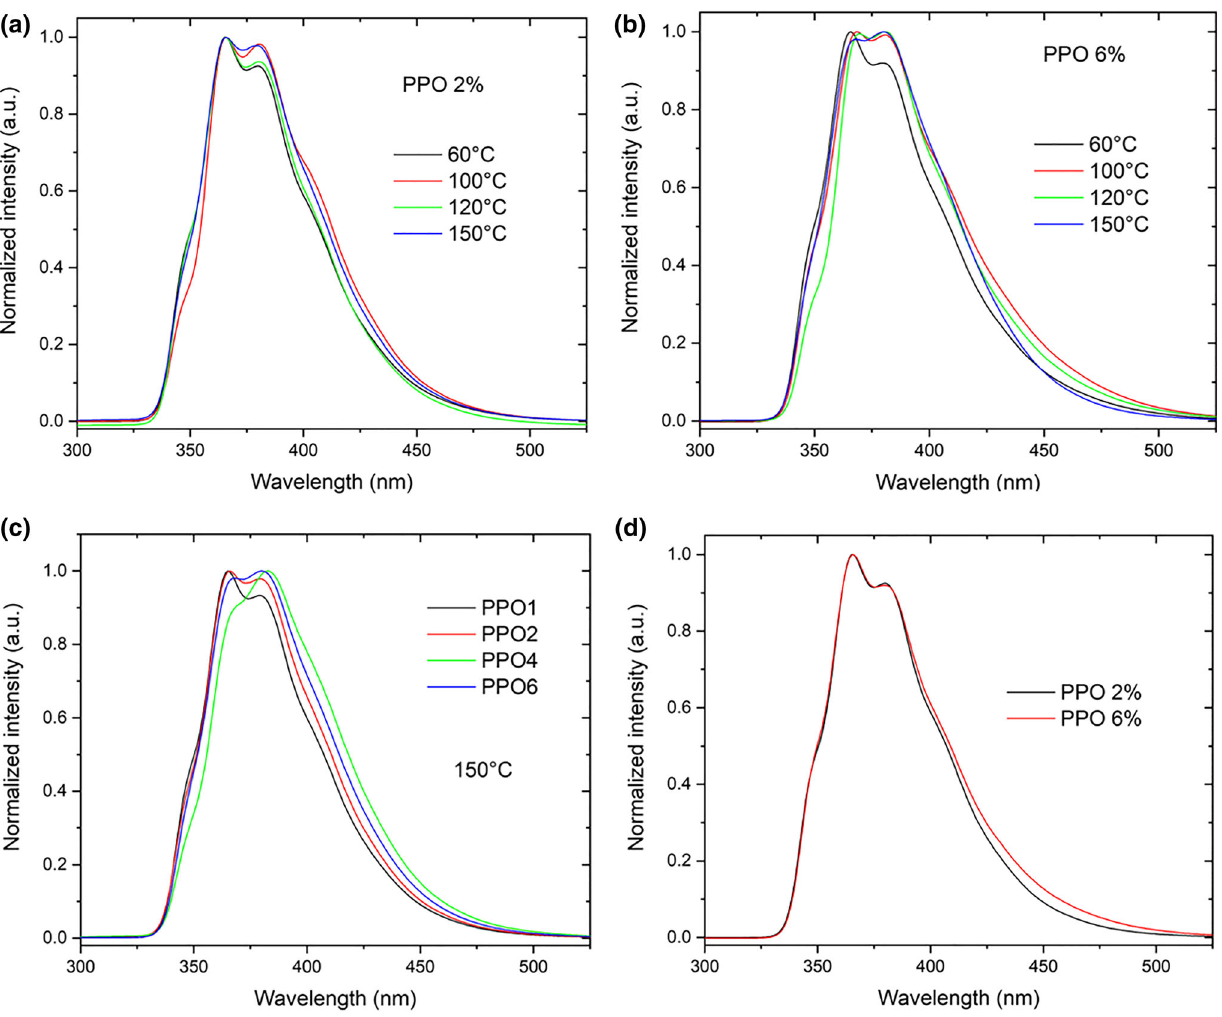
Fig. 4 Normalized fluorescence spectra collected a for samples of PMPS with 2% PPO and b 6% PPO after annealing at different temperatures, c for samples with increasing PPO treated at 150 ◦ C, d for untreated PMPS samples with 2 and 6% PPO. All the spectra are recorded using λ ex 280